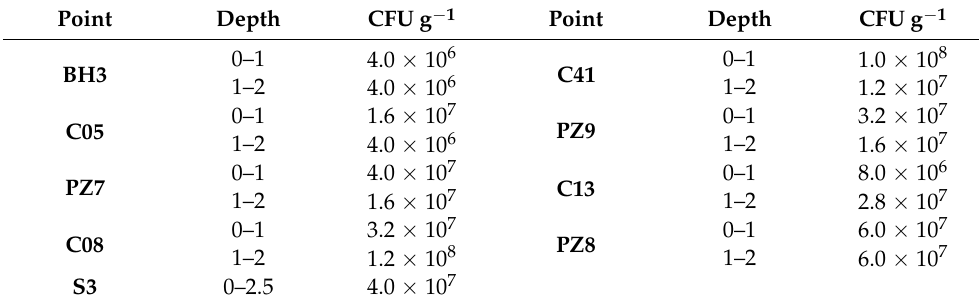
Table 4. Total microbial counts (expressed as colony forming units, CFU g − 1 ) of the cultivable microorganisms detected in the different soil samples. The CFUs obtained are sufficient to indicate possible ongoing biodegradation